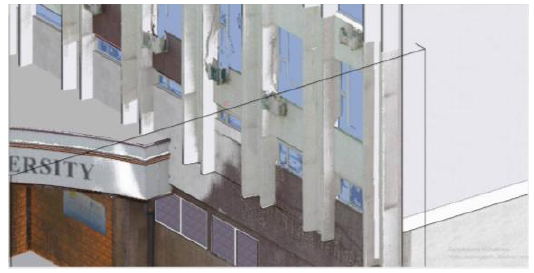
Figure 12. Binding function.